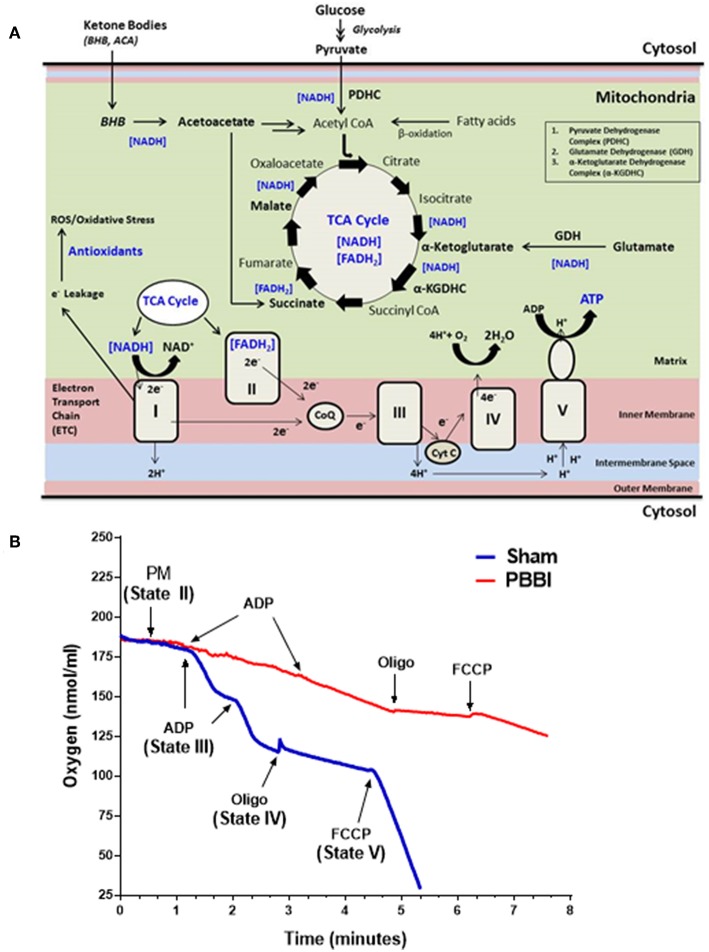
Overview of mitochondrial respiration following PBBI. (A) As illustrated in the schematic, brain mitochondrial substrates (i.e., glucose and ketone intermediates) oxidation leads to ATP synthesis through coordinated metabolic reactions of mitochondrial enzymes. Glucose oxidation yield pyruvate through glycolysis, which may further converted to acetyl CoA by enzyme PDHC. Glutamate may oxidized to α-Ketoglutarate by enzyme GDH. Ketone bodies (i.e., BHB or acetoacetate) may metabolized to acetyl CoA or Succinate. All brain energy metabolic substrates (i.e., pyruvate, glutamate, Succ, and BHB) oxidation increases the pool of reducing equivalents (i.e., NADH and FADH2); and donates electrons to Complex I or II of ETC enzyme complexes, which triggers the flow of electrons down to the final accepter O2 to form H2O at Complex IV. Concomitantly, proton-pumping from matrix to the intermembrane space by mitochondrial ETC complexes I, III, and IV generates the mitochondrial membrane potential (ΔΨm). The ΔΨm is then utilized to phosphorylate ADP to ATP through Complex V (i.e., ATP synthase). The complete oxidation of substrates in presence of O2 is linked with energy (i.e., ATP synthesis); therefore this process is termed as oxidative phosphorylation (OXPHOS). During OXPHOS, electron leaks (~2% electron leak) from mitochondrial ETC may generate reactive oxygen and nitrogen free radical species (i.e., ROS and RNS, respectively) and subsequent oxidative stress; which are counterbalanced by antioxidants in uninjured brain. (B) Representative traces PM-driven mitochondrial respiration in PBBI and sham groups. Briefly, incubate 50 μg of mitochondrial protein into the sealed Clark-type oxygen electrode chamber containing KCl-based respiration buffer (Hansatech Instruments, England). In the real-time condition, sequentially add metabolic substrates/inhibitors of the mitochondrial respiration chain i.e., PM (~1 min), ADP (~2–3 min), oligomycin (~4 min), and FCCP (~6 min) to measure oxygen consumption rates (nmols/ml). The illustrated mitochondrial bioenergetics parameters a.k.a. State II respiration (i.e., basal respiration in presence of PM as the substrate set); State III respiration (ATP synthesis in presence of ADP); State IV respiration (i.e., proton leakage in presence of ETC complex V inhibitor oligomycin); and State V respiration (i.e., uncoupled respiration rates in presence of mitochondrial ETC uncoupler FCCP) were measured for each mitochondrial samples. Similarly, other mitochondrial substrates (i.e., GM, Succ, and BHBM) driven respiration rates were quantified separately. As noted here, the PBBI group (red trace) displayed reduced PM driven ATP synthesis (State III) and uncoupled respiration (State V) compared to sham (blue trace) group.